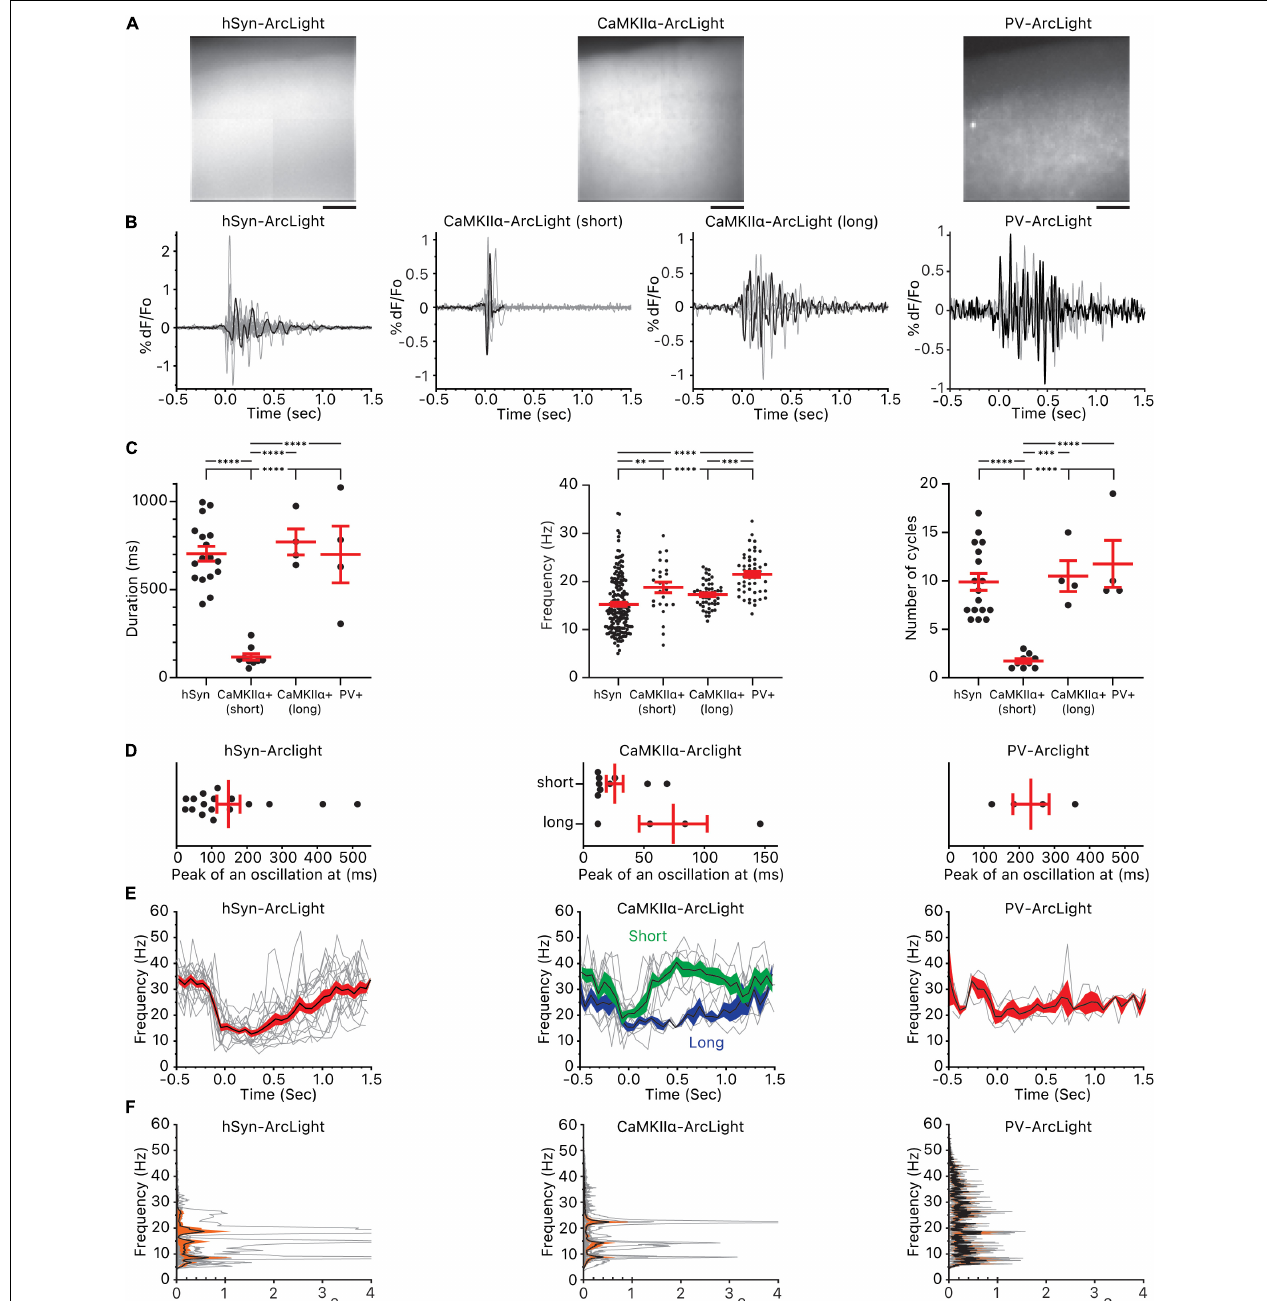
FIGURE 3 | Oscillations observed in all cells, CaMKII α + cells, and PV+ cells. (A) Pattern of pan-neuronal, CaMKII α +, and PV+ ArcLight expression in the motor cortex. Scale bar below the images are 100 µ m. (B) Individual oscillation waveforms (gray) and the representative oscillation waveform (black) plotted over time. The number of mice, slices, and oscillations for each group are as follows: hSyn-ArcLight, 4 mice, 5 slices, 17 oscillations. CaMKII α -ArcLight (short), 2 mouse, 5 slices, 9 oscillations. CaMKII α -ArcLight (long), 1 mouse, 2 slices, 4 oscillations. PV-ArcLight, 2 mice, 2 slices, 4 oscillations. (C) Total duration of the oscillations, frequency, and the number of cycles of the oscillations. ∗∗ p < 0.01, ∗∗∗ p < 0.001, and ∗∗∗∗ p < 0.0001 for one-way ANOVA and Tukey’s multiple comparisons test. (D) Timing of the absolute maximum % (cid:49) F/F 0 after the onset of the oscillations. (E) Frequencies of the individual oscillation waveforms (gray), the mean (black), and the squared error of the mean (red) of the frequencies plotted over time. The squared error of the mean for CaMKII α -ArcLight (short) is shaded in green and the squared error of the mean for CaMKII α -ArcLight (long) is shaded in blue. (F) Power spectral densities of the individual oscillation waveforms (gray), the mean (black), and the squared error of the mean (orange) of the power spectral densities plotted over frequency. hSyn, hSyn-ArcLight; CaMKII α +, CaMKII α -ArcLight; PV+, PV-ArcLight.